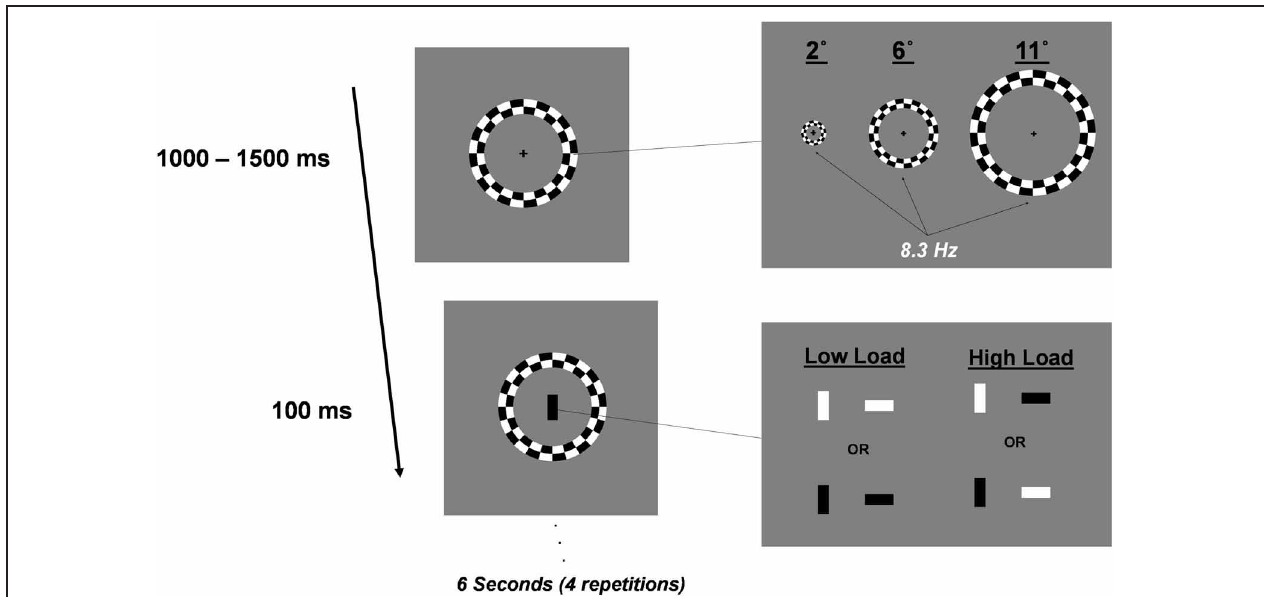
FIGURE 1 | Schematic representation of stimuli and trial progression. Distractor stimuli were one of three rings centered at 2, 6, or 11 ◦ from fixation. Distractor stimuli contrast reversed at 8.3Hz. Foveal stimuli were black or white rectangles oriented vertically or horizontally. Subjects performed a go/no-go task, responding to two targets that were assigned for